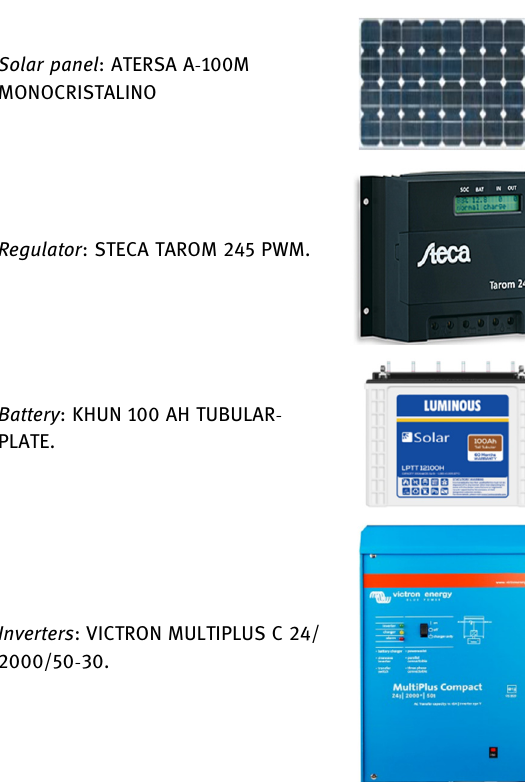
Solar panel : ATERSA A - 100M MONOCRISTALINO